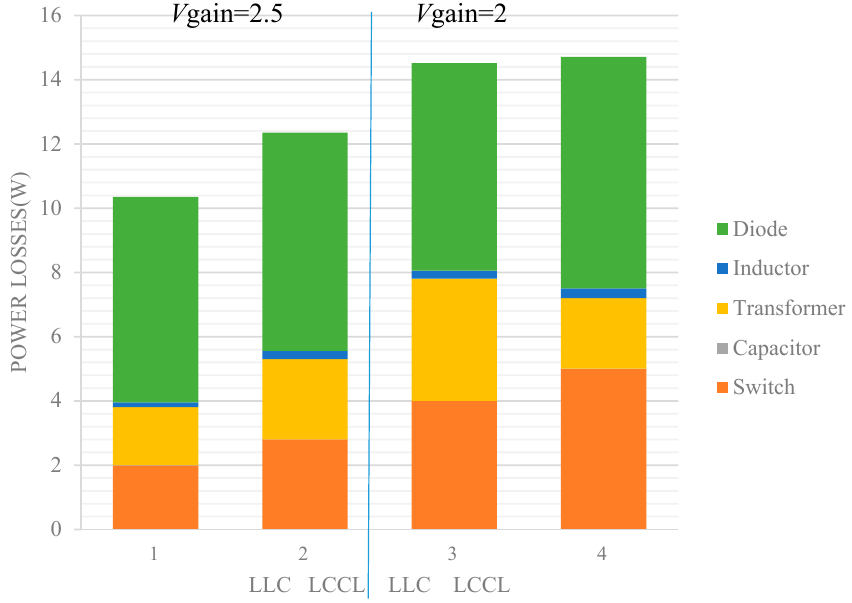
Figure 10. The calculated efficiency comparison of the LLC and LCCL under different gain conditions.